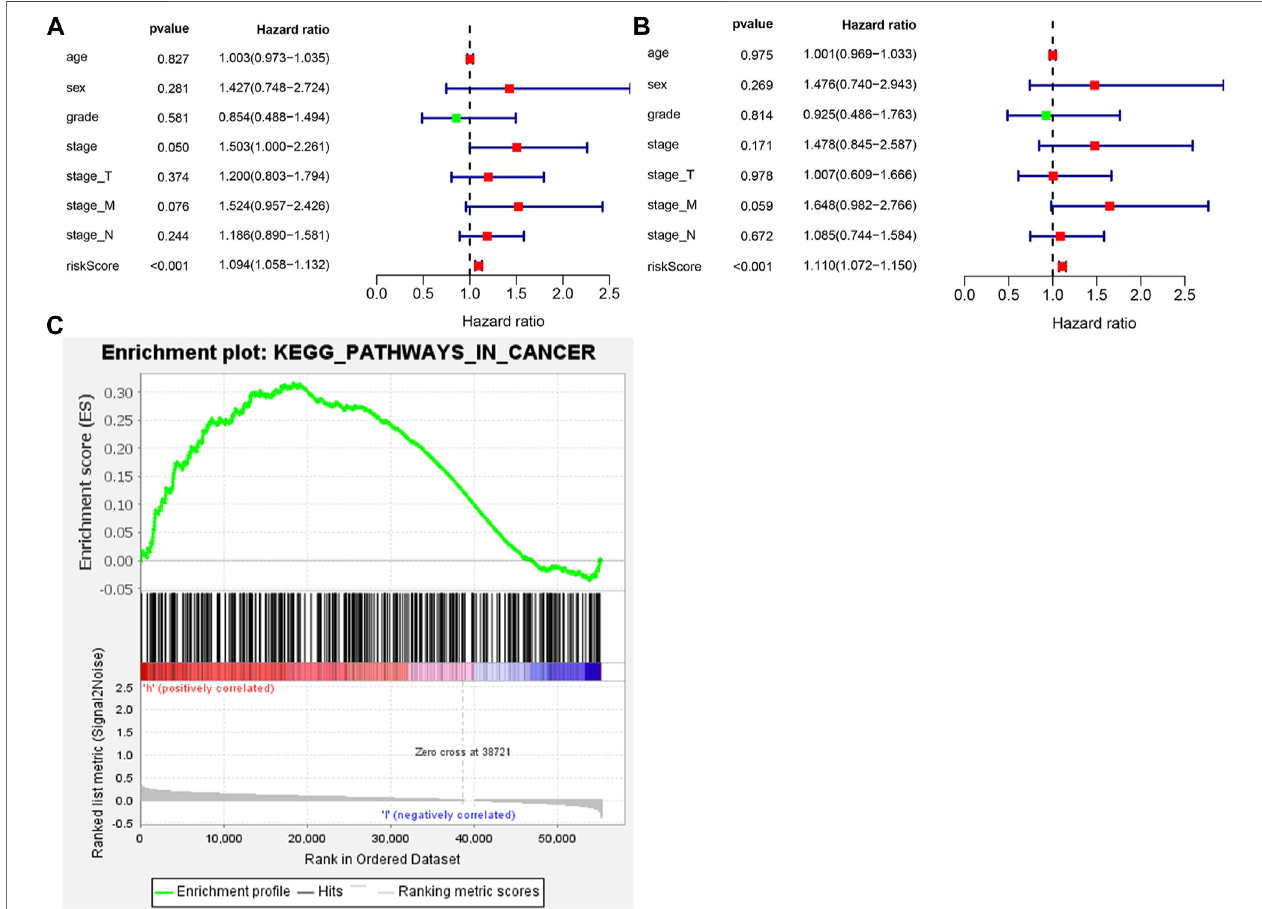
FIGURE 3 | The ATGs for OS is an independent prognostic factor for GC. (A) Univariate Cox regression analysis of correlations between the risk score for OS and clinicalvariables. (B) MultivariateCoxregressionanalysisofcorrelationsbetweentheriskscoreforOSandclinicalvariables. (C) Genesetenrichmentanalysiscomparing the high - and low -risk